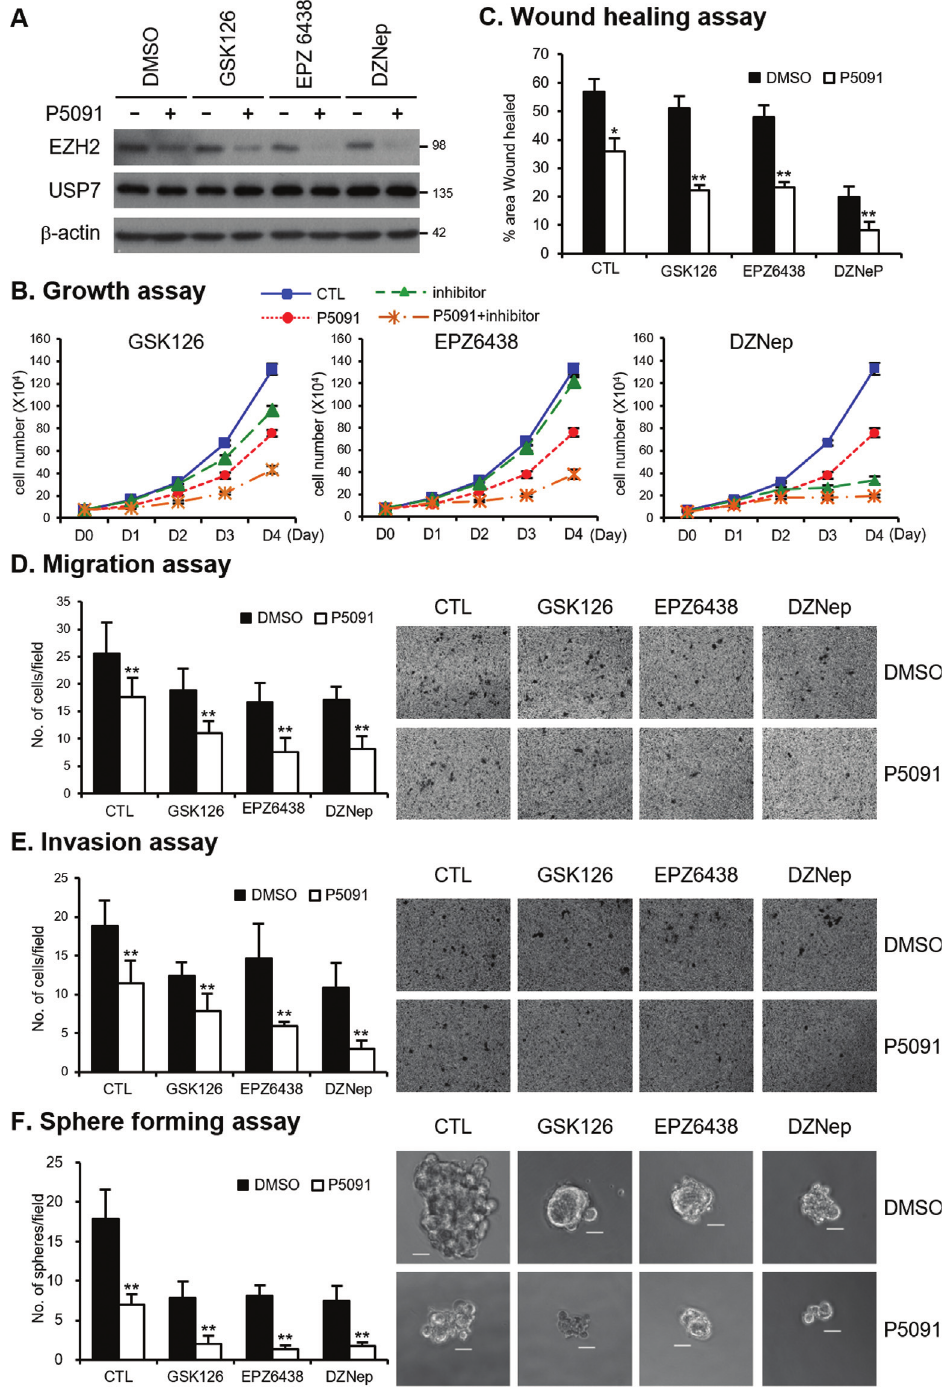
Figure 6 - Simultaneous treatment with P5091 and EZH2 inhibitor induces synergistic effects in DU145. (A) DU145 cells were treated with GSK126 (5 (cid:2) M),EPZ6438(20 (cid:2) M),andDZNep(0.5 (cid:2) M)intheabsenceorpresenceofP5091(2.5 (cid:2) M)for48h.Celllysateswereimmunoblottedwithanti-EZH2or anti-USP7antibody.(B)GrowthcurvesofDU145cellstreatedwithGSK126(5 (cid:2) M),EPZ6438(10 (cid:2) M),andDZNep(0.5 (cid:2) M)intheabsenceorpresence of P5091 (2.5 (cid:2) M), as indicated. Viable cells were counted by trypan blue-exclusion assay every 24 h after cell seeding. (C) Wound healing assays of DU145 cells treated with GSK126 (5 (cid:2) M), EPZ6438 (10 (cid:2) M), and DZNep (0.5 (cid:2) M) in the absence or presence of P5091 (2.5 (cid:2) M), as indicated. (D) Mi- grationassaysofDU145cellstreatedwithGSK126(5 (cid:2) M),EPZ6438(20 (cid:2) M),andDZNep(0.5 (cid:2) M)intheabsenceorpresenceofP5091(2.5 (cid:2) M),asin- dicated.(E)MatrigelinvasionassaysofDU145cellstreatedwithGSK126(5 (cid:2) M),EPZ6438(20 (cid:2) M),andDZNep(0.5 (cid:2) M)intheabsenceorpresenceof P5091 (2.5 (cid:2) M), as indicated. (F) Sphere formation assays of DU145 cells treated with GSK126 (5 (cid:2) M), EPZ6438 (20 (cid:2) M), and DZNep (0.5 (cid:2) M) in the absence or presence of P5091 (2.5 (cid:2) M), as indicated. The figure shows representative images from each cell, and the scale bar is 100 (cid:2) m. Values are ex- pressed as the mean (cid:6) SD of three independent experiments (C–F). The p value was obtained by Student’s t -test. * p < 0.05, ** p <